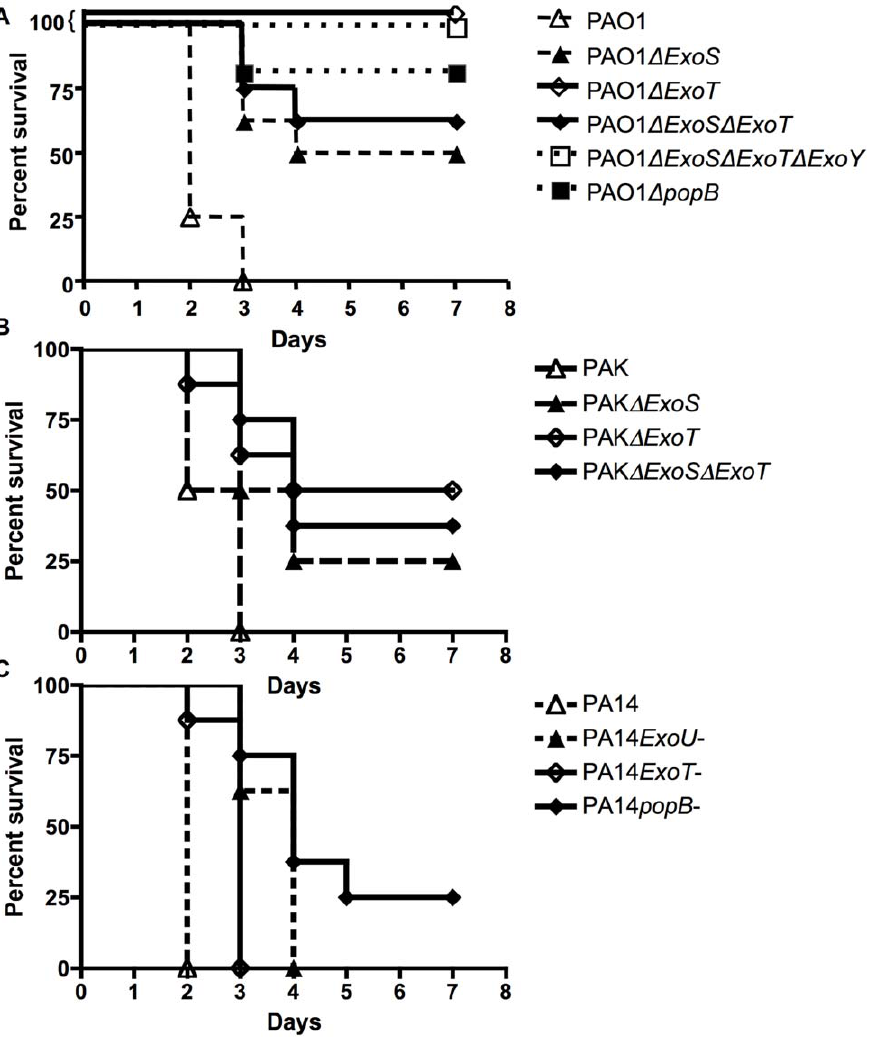
Figure 6. Survival curves of neutropenic mice colonized with wild-type P.aeruginosa and T3SS mutant strains. Female 6–8 wk-old C3H/ HeN mice were colonized with P. aeruginosa strains PAO1(A), PAK (B), and PA14 (C) and with various deletional or insertional mutations of the type III secretion system in the corresponding WT background and then subsequently made neutropenic with monocloncal antibody RB6-8C5 (0.200 mg IP once). Median survival of mice colonized with mutants was significantly higher than that of mice colonized with the corresponding wildtype strain (P , 0.009 for PAO1 mutants, P , 0.009 for PAK mutants, P , 0.006 for PA14 mutants, log-rank test). Each group contained 8 mice. T3SS, type III secretion